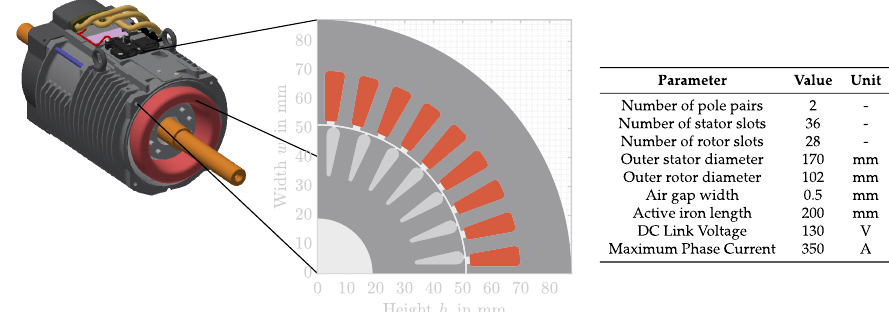
Figure 10. Cross section and parameter of the exemplary